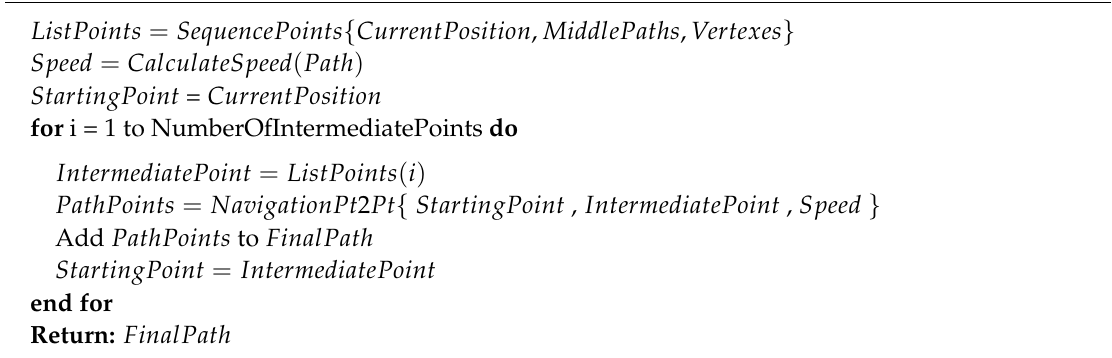
Algorithm 13 CalculatePath{ Position , Path , MiddlePaths , Vertexes } ListPoints = SequencePoints { CurrentPosition , MiddlePaths , Vertexes